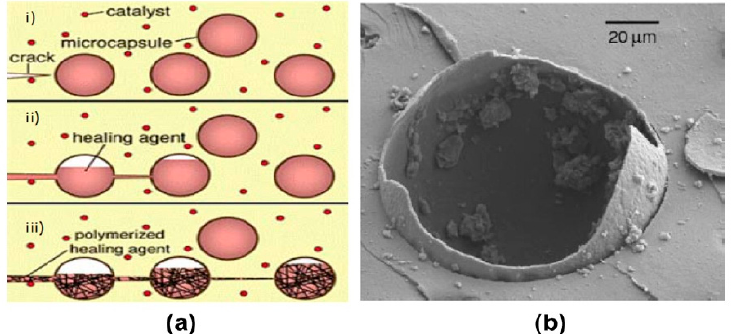
Figure 8. ( a ) The microencapsulation approach and ( b ) typical Field Emission Scanning Electron Microscope (FESEM) micrograph of a cracked microcapsule [69] .